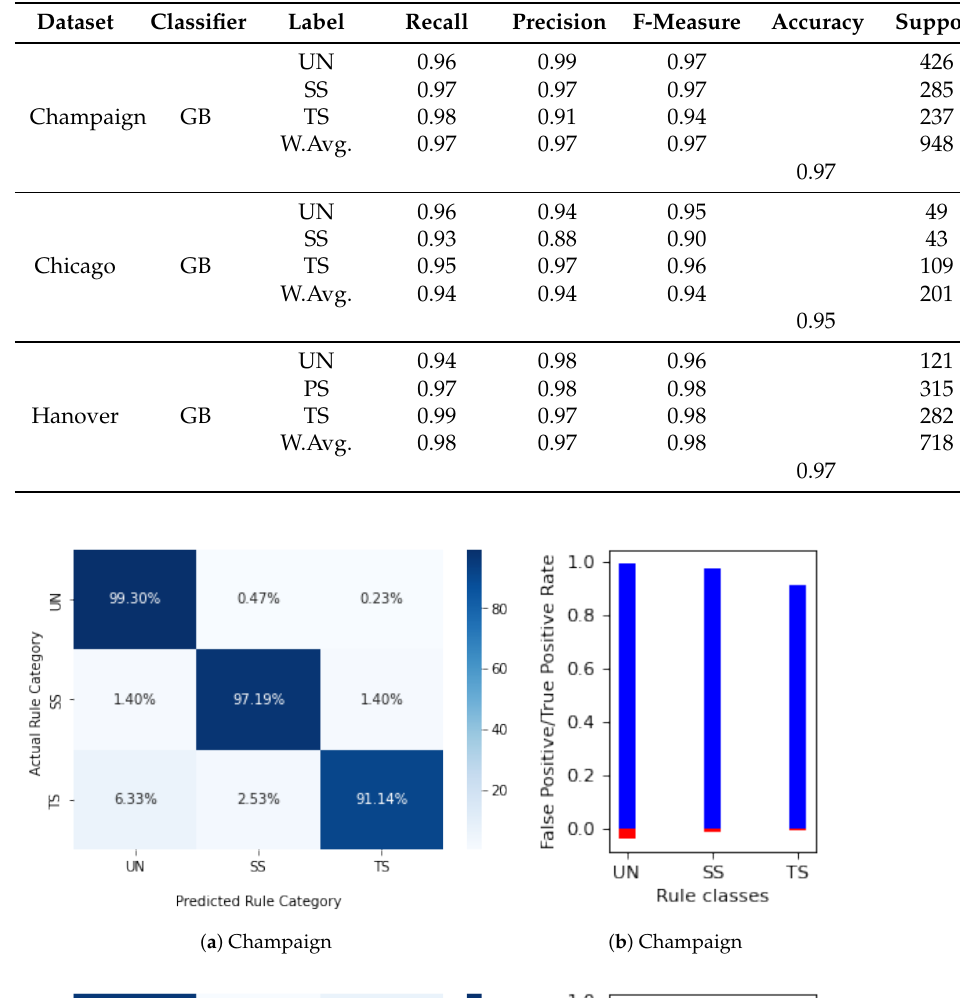
Table 8. Classification results of the tuned hybrid all-static model after applying a consistency check of domain knowledge rules.